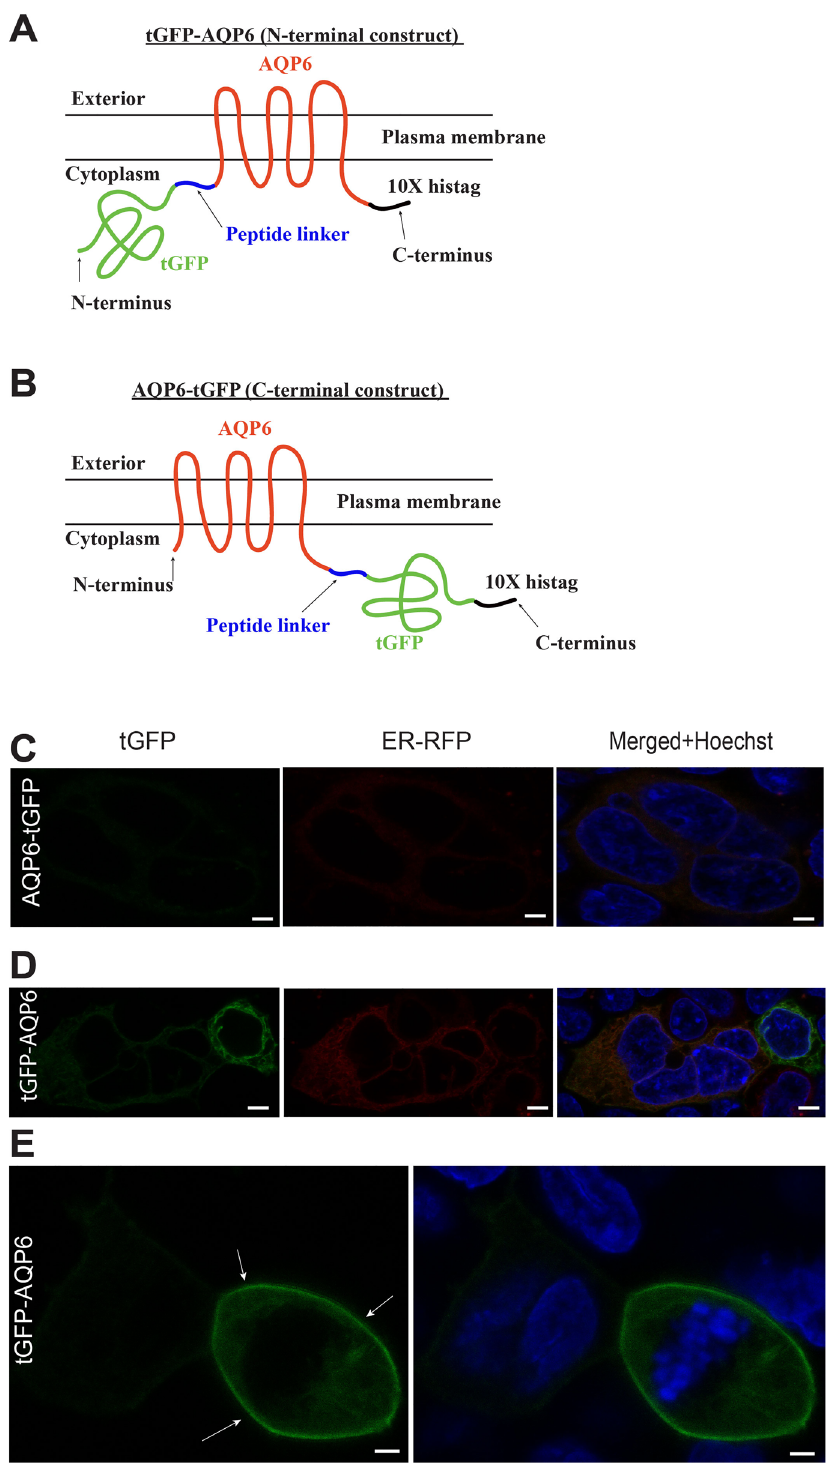
Figure 1. AQP6 expressed in transient heterologous transfection constructs rarely reaches the plasma membrane. ( A ) The N-terminal tGFP-labeled AQP6 construct is shown (tGFP-AQP6). The peptide linker is shown in blue and the C-terminal 10× Histag in black. ( B ) The C-terminal GFP-labeled AQP6 construct is shown (AQP6-tGFP). The peptide linker is shown in blue and the C-terminal 10× Histag in black. ( C ) Transient transfection of an AQP6-tGFP construct in HEK293 cells yields very poor to no expression. ( D ) Transient transfection of tGFP-AQP6 construct in HEK293 cells improves expression but most of the expressed protein is retained in the ER. Scale bars ( C , D ): 5 µm. ( E ) Very rarely, the tGFP-AQP6 construct localizes to the PM (white arrows) in HEK293 cells. Scale bar: 3 µm. Cells were observed microscopically using an upright Olympus BX51WI equipped with 100 × 1 NA objective, and images were captured using a Grasshopper3 CMOS camera (FLIR, Richmond, BC, Canada) controlled by Leica LAS X version 3.5 software (available at: https:// www. leica- micro syste ms. com/ produ cts/ micro scope- softw are/p/ leica- las-x- ls/). All figures were created using Adobe Illustrator CS6 (available at: https:// adobe. com/ produ cts/ illus trator), under an Adobe Inc., Creative Cloud Desktop 2019 shared device license to Case Western Reserve University (CWRU) that operates until